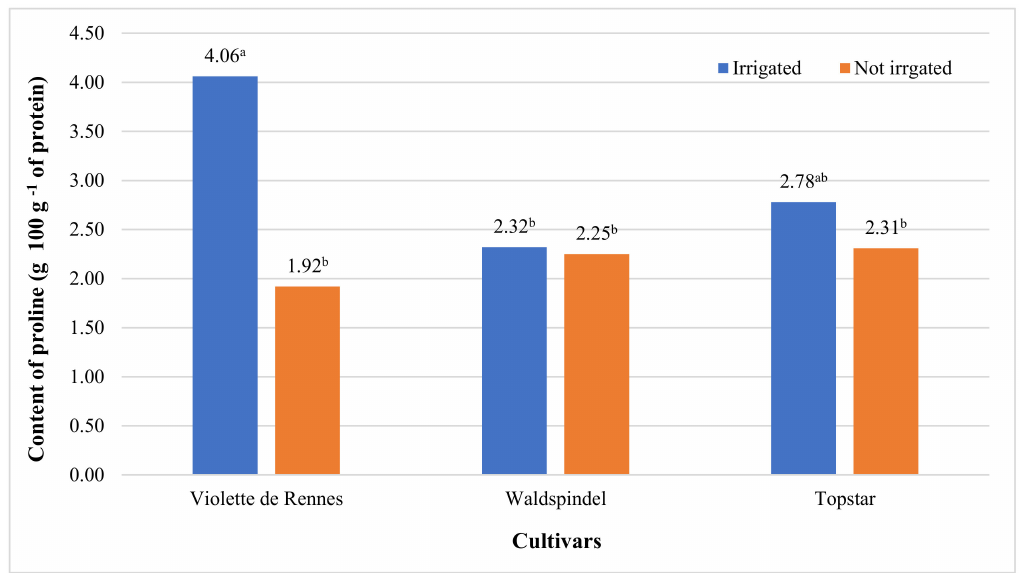
Figure 8. The e ff ect of irrigation on the proline content of tubers in the analyzed Jerusalem artichoke cultivars. Means with the same letters do not di ff er significantly at p ≤ 0.05 in Tukey’s test. The absence of letters denotes non-significant main e ff